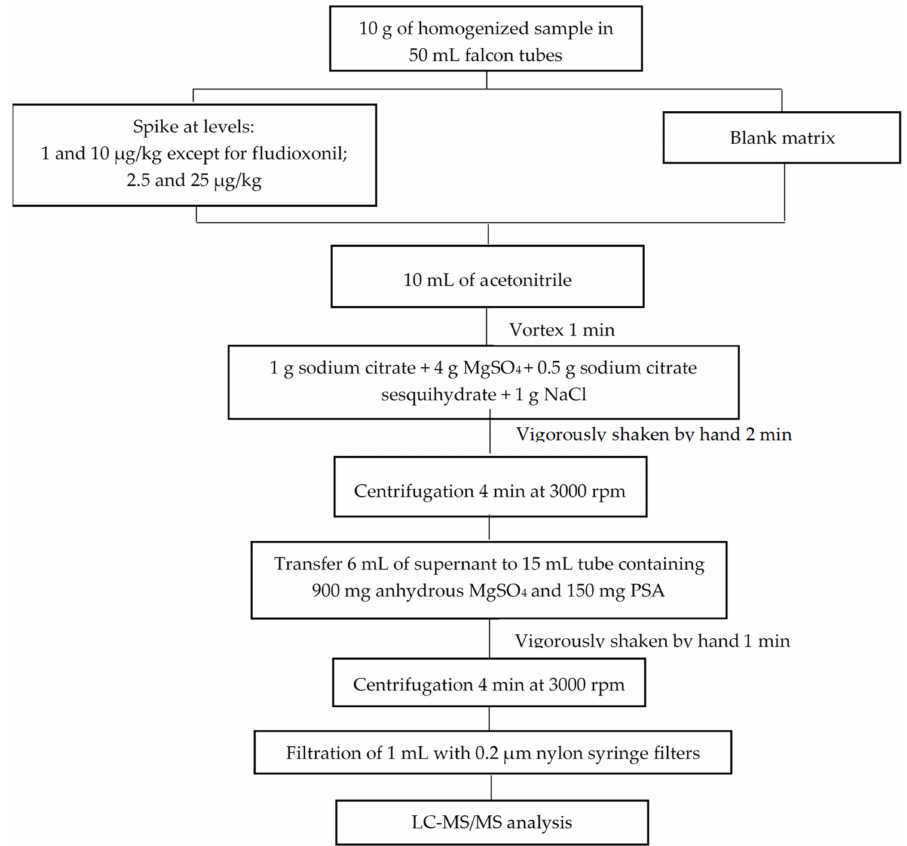
Figure 2. Scheme of the QuEChERS extraction